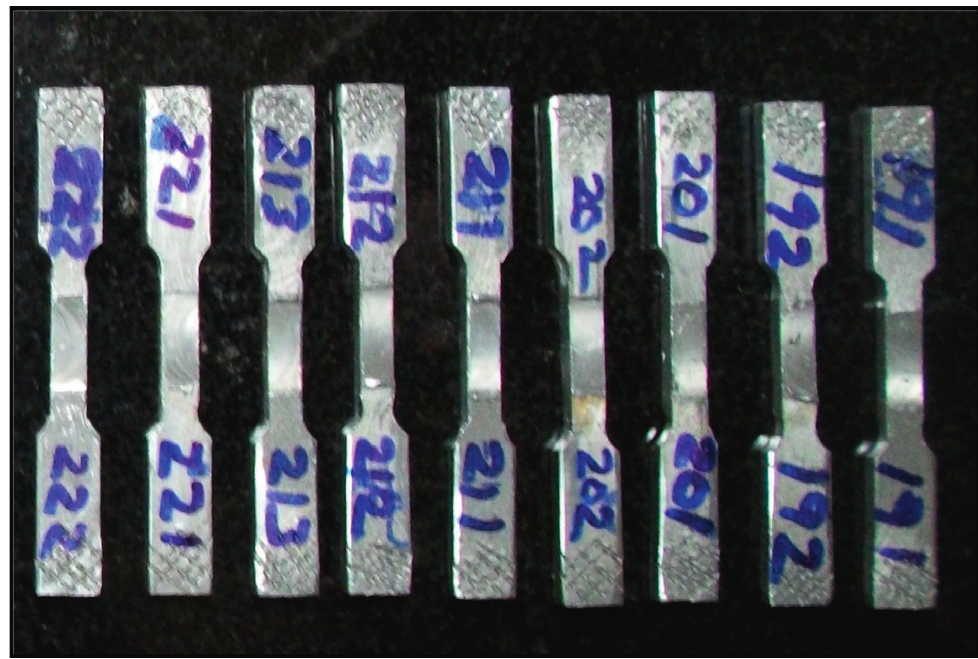
Figure 5: Fabricated tensile specimens as per the ASTM: E8/E8 M-11